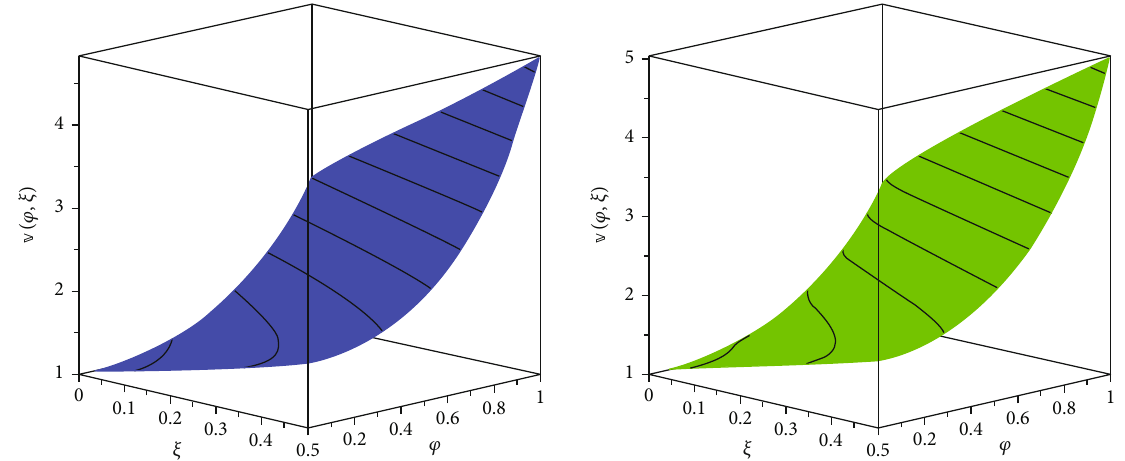
Figure 5: The di ff erent fractional-order of ℘ = 0 : 6 and 0.4 of Example 10.